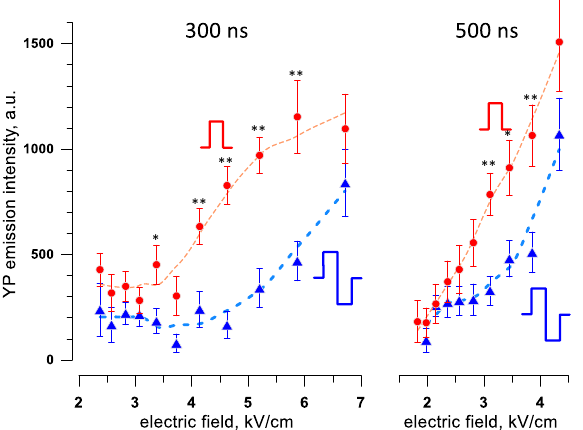
Figure 8. The addition of the opposite polarity second phase inhibits the electroporative uptake of YO-PRO-1 dye (YP) in a broad range of supra-threshold electric field strengths. Measurements were performed in cell samples exposed to 300-pulse trains at 10 Hz. Unipolar pulse duration and one phase duration of bipolar pulses was 300 ns (left panel) or 500 ns (right panel). YP was added to cell samples before pulse exposure and washed away 30 min after it. Dashed lines are the LOESS function best fits. * p < 0.05, ** p < 0.01 for the difference between bipolar and unipolar pulses, with two-tailed t test. See text for more details.